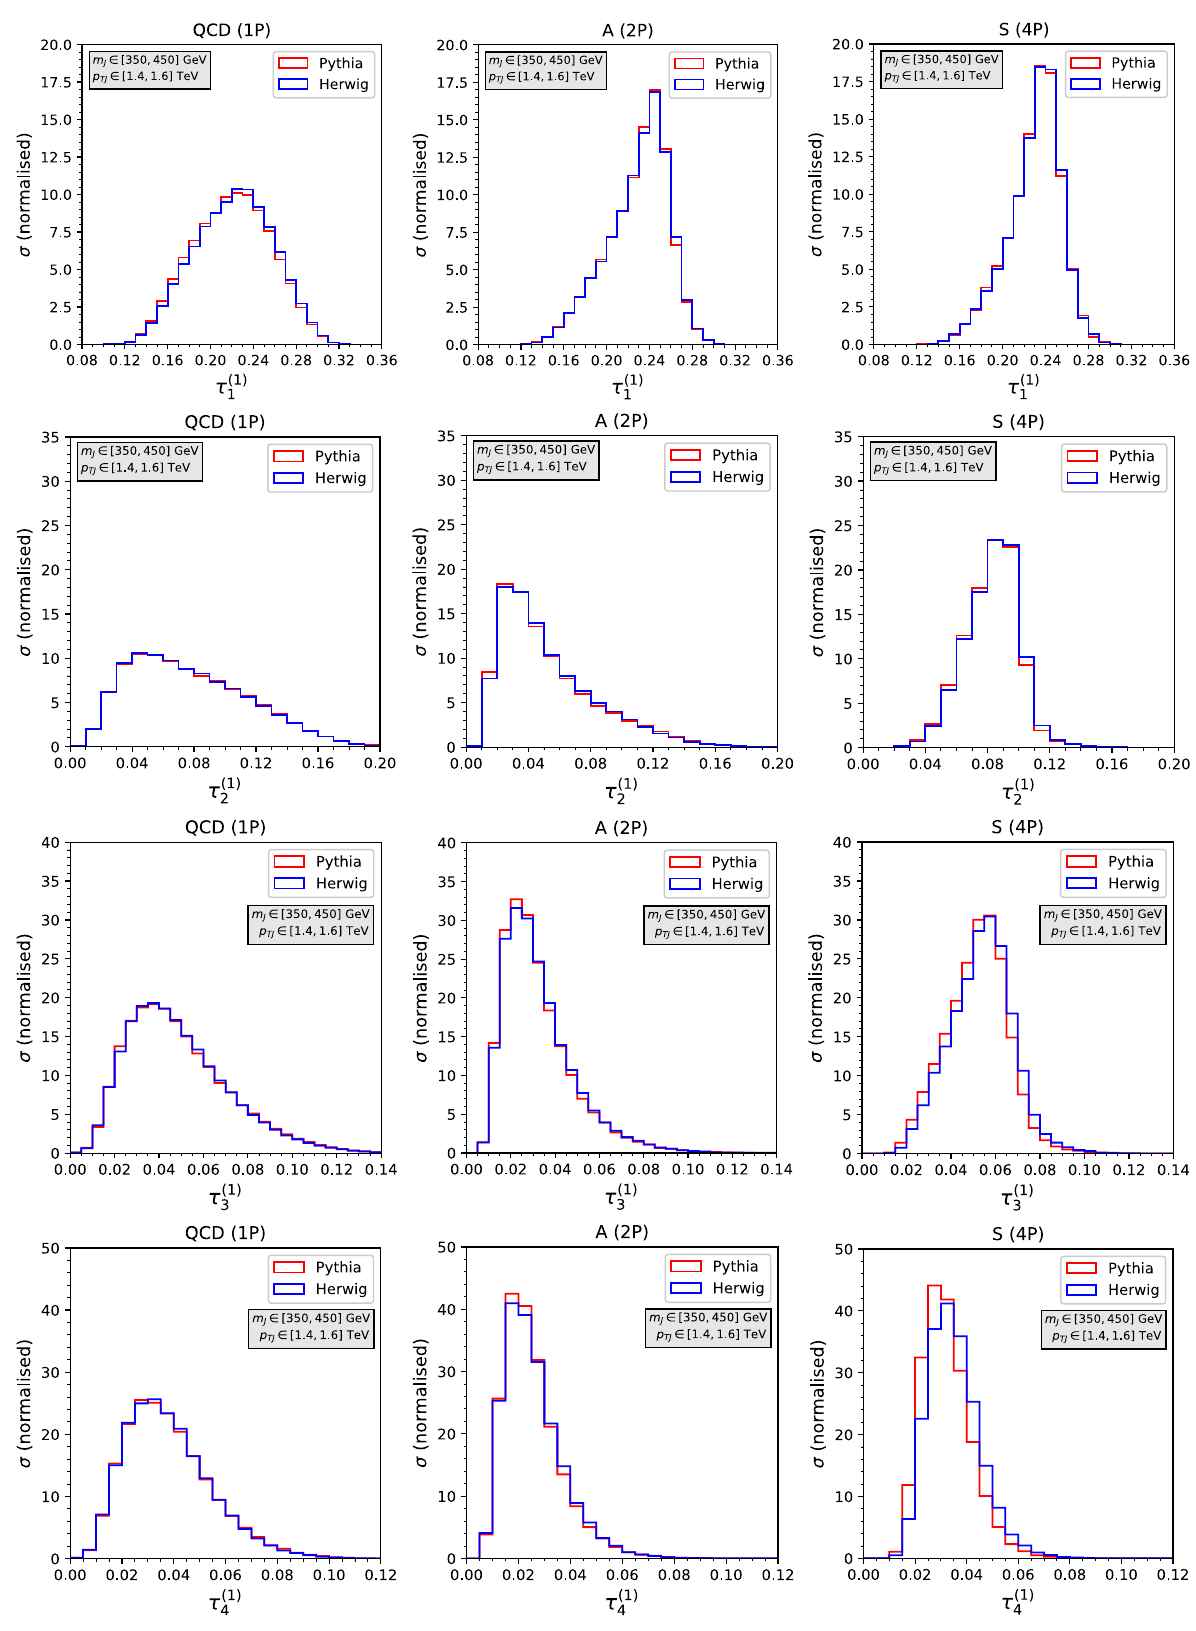
Fig. 2 Normalised distributions of τ ( 1 ) n with n = 1 , 2 , 3 , 4, for QCD and multi-pronged jets with m J ∈ [ 350 , 450 ] GeV (see the text for